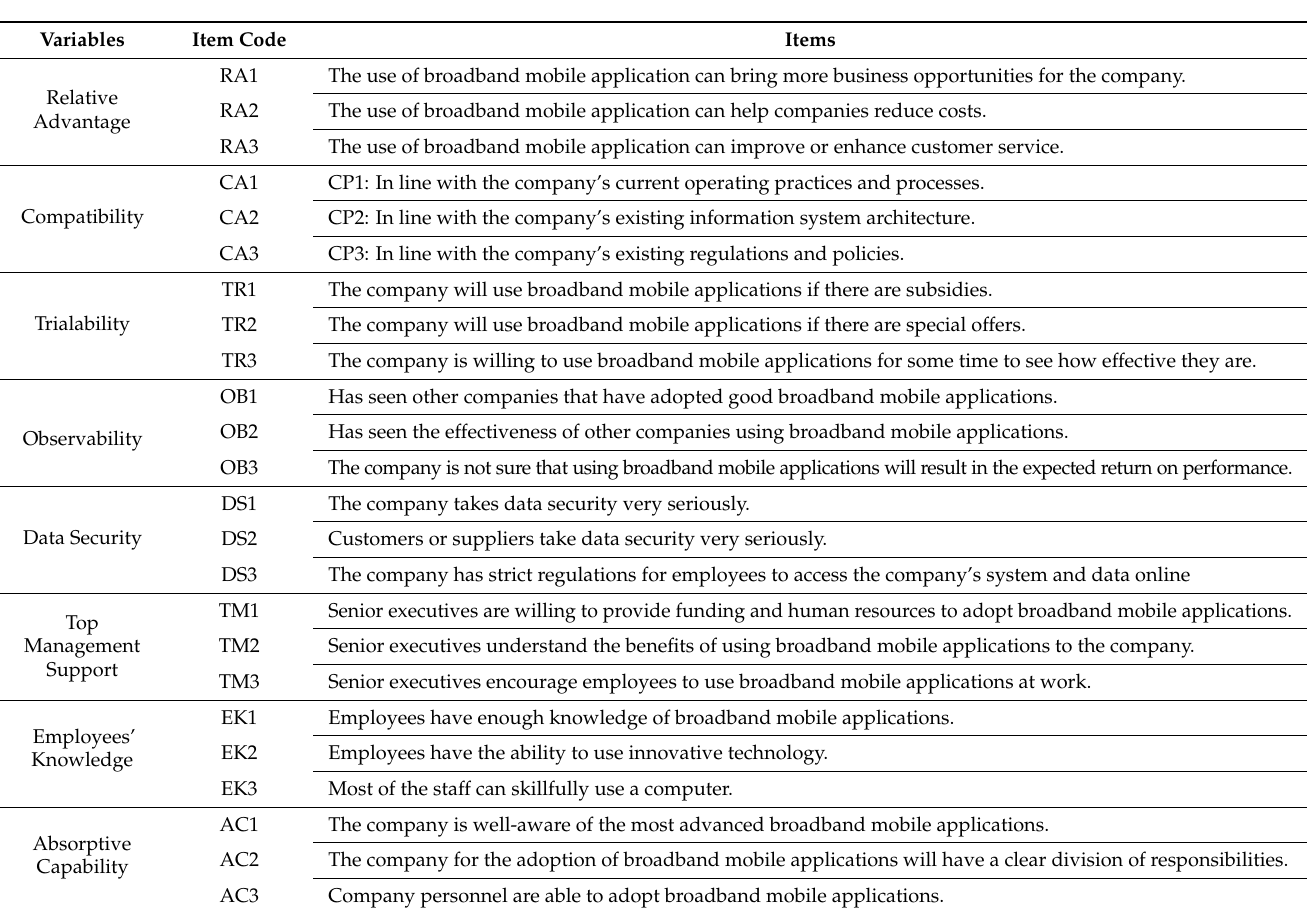
Table A5. Variables and